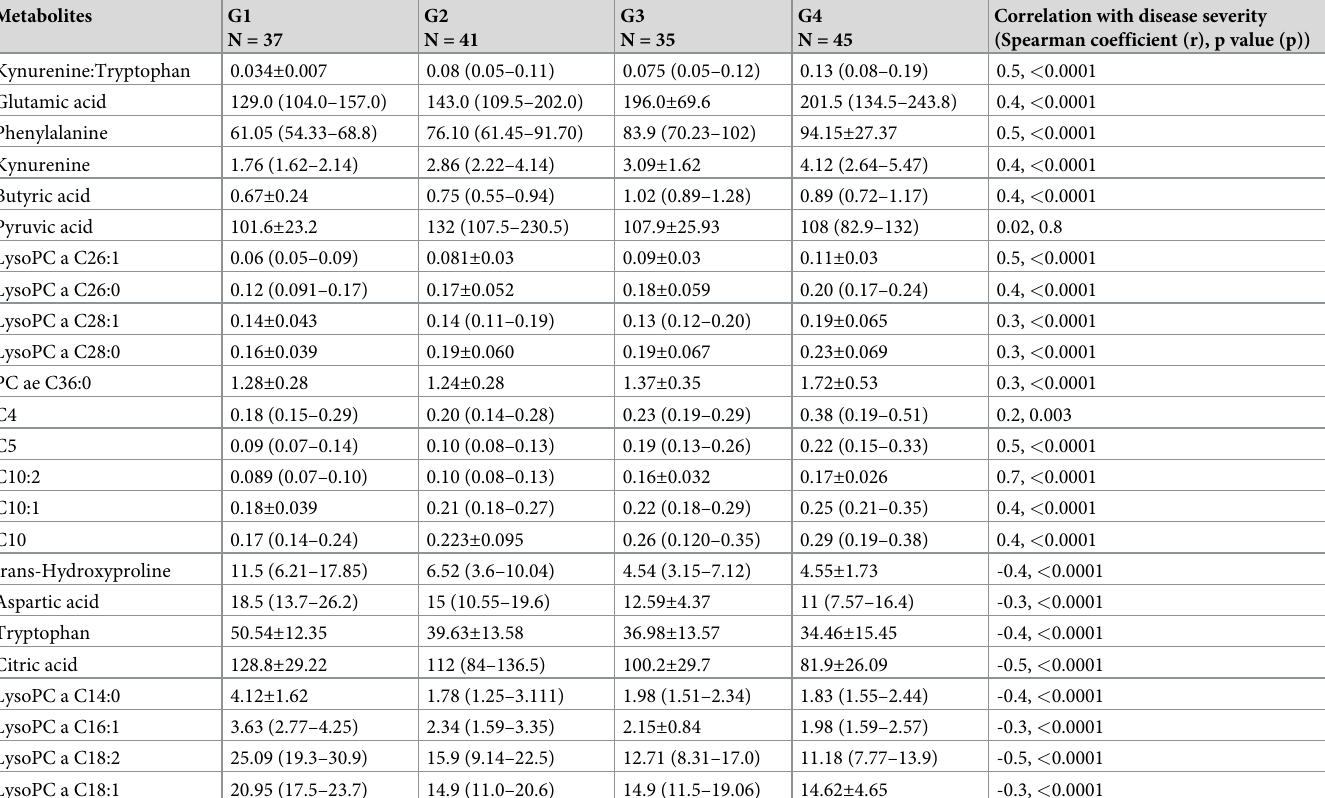
Table 2. Plasma concentration values (micromoles) of dysregulated metabolites according to disease severity.